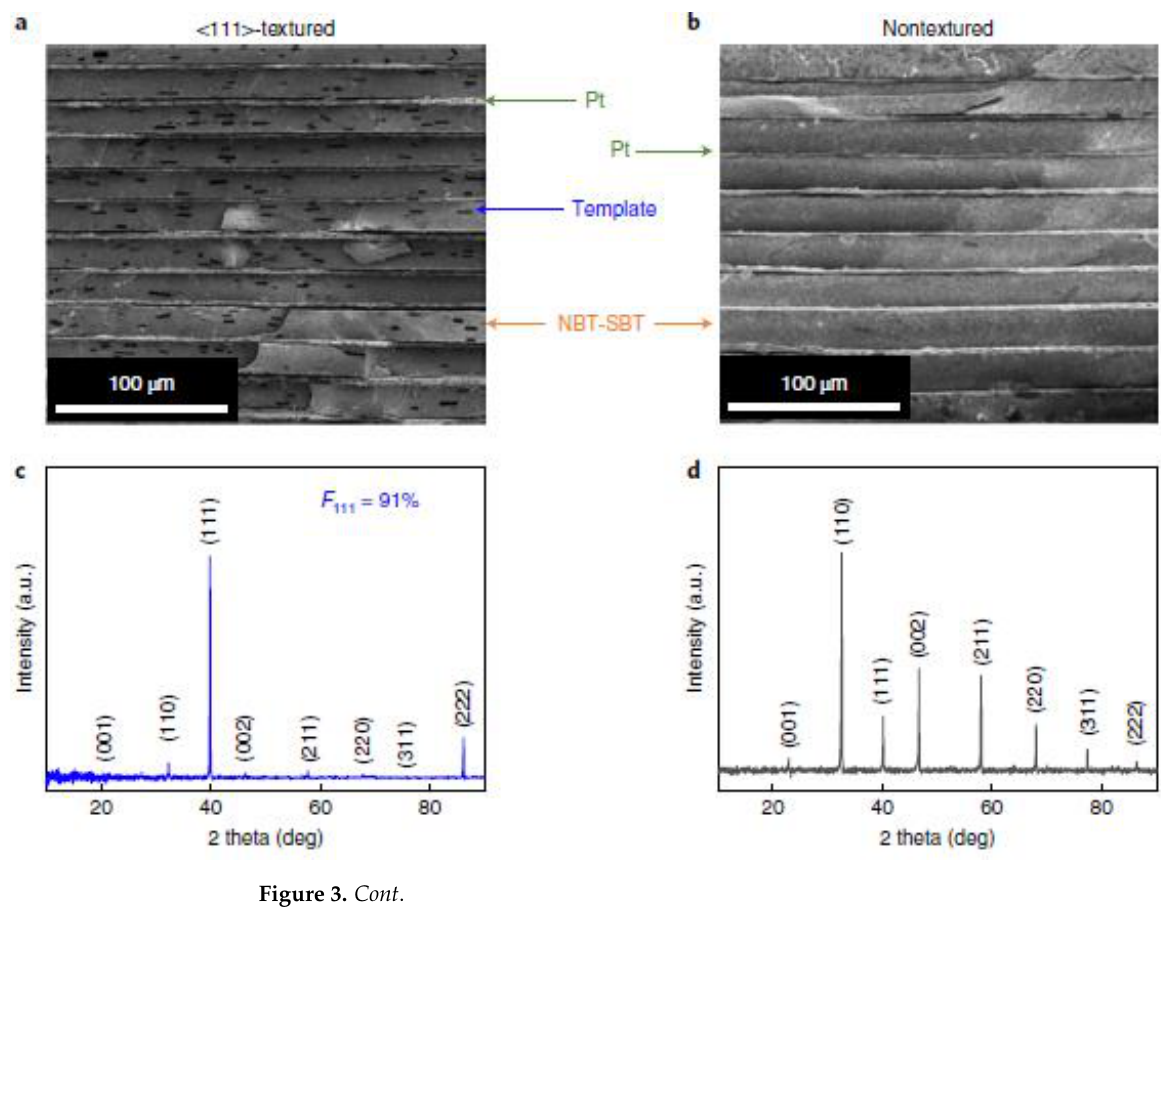
Figure 2. SEM image of ( a ) the surface and ( b ) the cross section of the 0.4BNT-0.6BTBZNT MLCCs. The inset shows the grain size distribution of the 0.4BNT-0.6BTBZNT MLCCs [47].